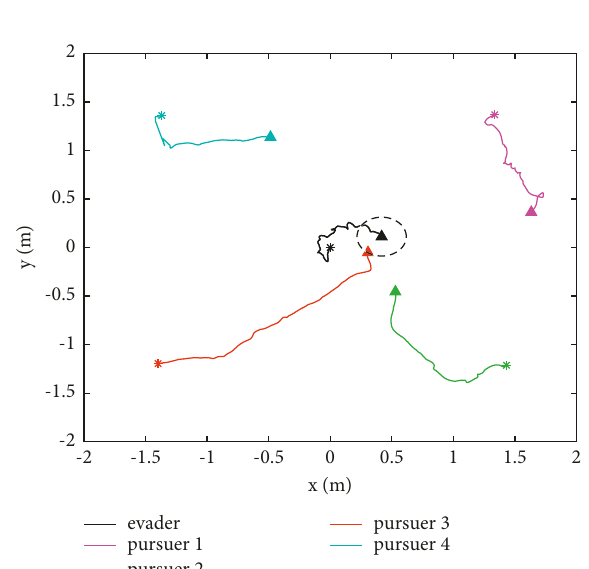
Figure 13: Position trajectories of quadrotors ( N � 4, λ � 0 . 9).